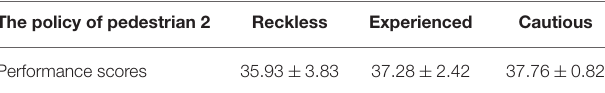
TABLE 3 | The bystander’s performance scores.